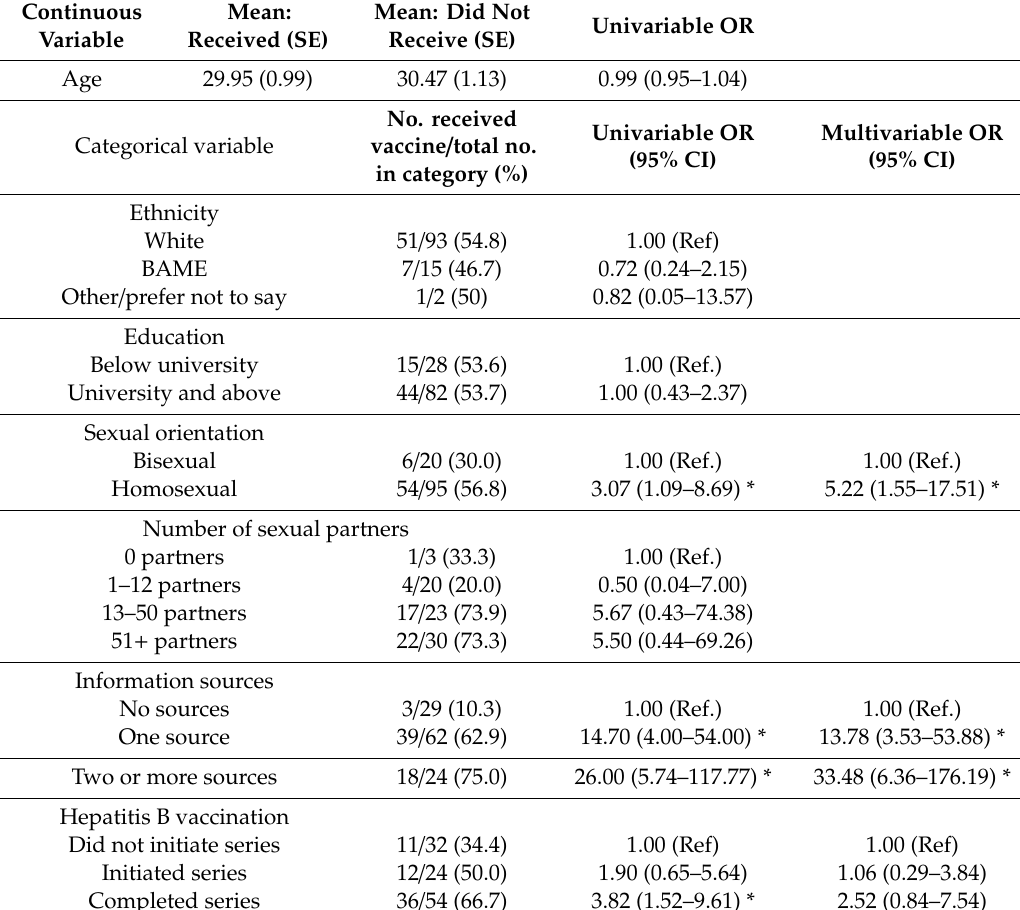
Table 2. Univariable and multivariable correlates of vaccine uptake. n = 115 1